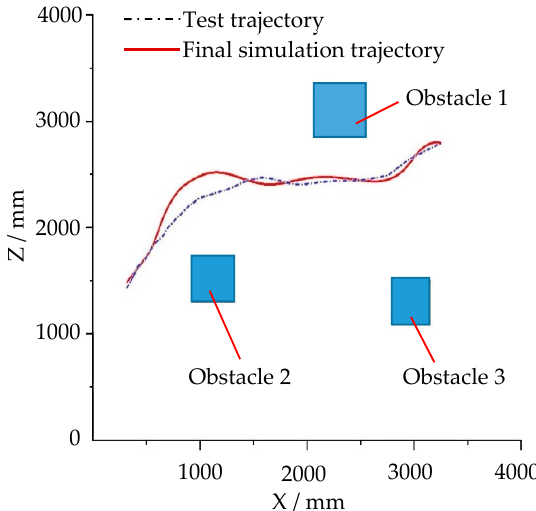
Figure 42. The test trajectory in the physical environment and final simulation trajectory.